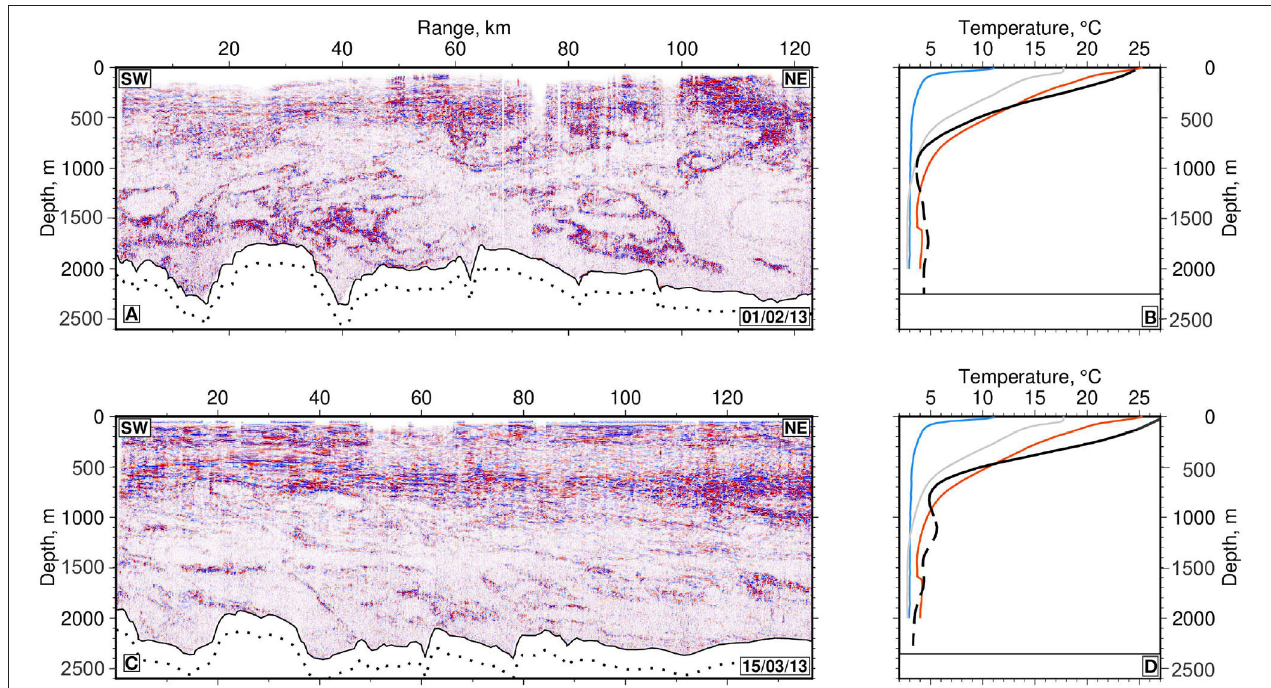
FIGURE 7 | (A) Section A of seismic reflection survey. (B) Conservative temperature as function of depth. Black line = horizontally averaged temperature profile calculated for Section A using iterative inversion procedure; dashed line = portions of same profile where calculation is uncertain due to lack of continuous reflections at depths & 1,000 m; red/blue/gray lines = average temperature profile obtained from GO-SHIP hydrographic sections A10/A11/A17, which represent subantarctic/subtropical/mixed water masses, respectively (see Figure 1A ). (C) Section C of seismic reflection survey. (D) Same as (B) for Section